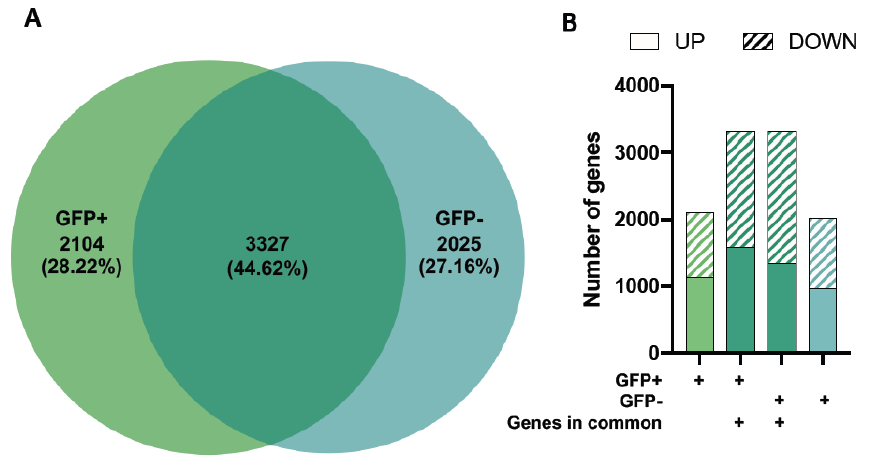
Figure 2. Differential gene expression in GFP+ (RRV-infected) and GFP-mock (uninfected bystander) populations. Differentially expressed genes (DEGs) for GFP+ and GFP − cells relative to healthy mock controls were compared and the proportion of genes expressed as a Venn diagram ( A ). Up- and down-regulated DEGs in each of the four gene profiles (genes in the GFP+ group only, overlapping genes which are present in GFP+ cells, overlapping genes which are present in GFP − cells and genes that are found in the GFP − group only) are shown ( B ).